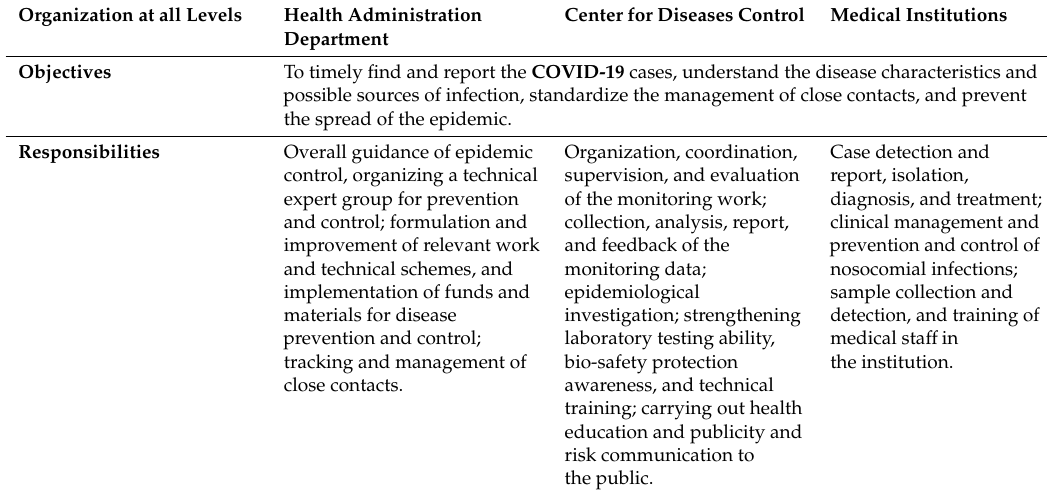
Table 2. Responsibilities for the di ff erent organizations at all (province, city, county, district, township, and street) levels in the outbreak of